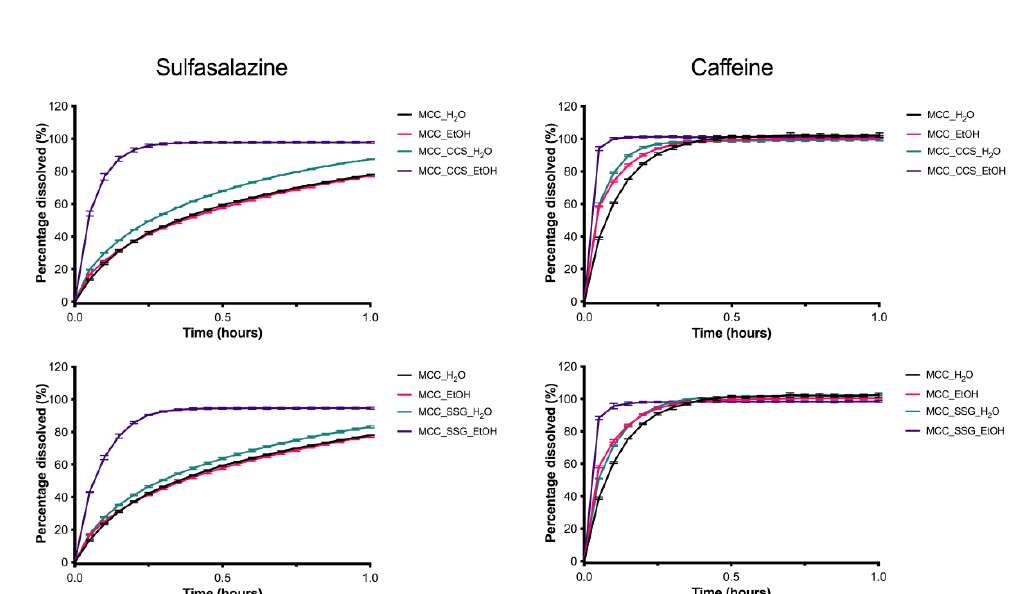
Figure 1. Influence of excipients and pelletizing liquid on the release profile of SAS ( left ) and CAF ( right ) in 1000 mL GISS phase III (mean ± SD, n = 3).